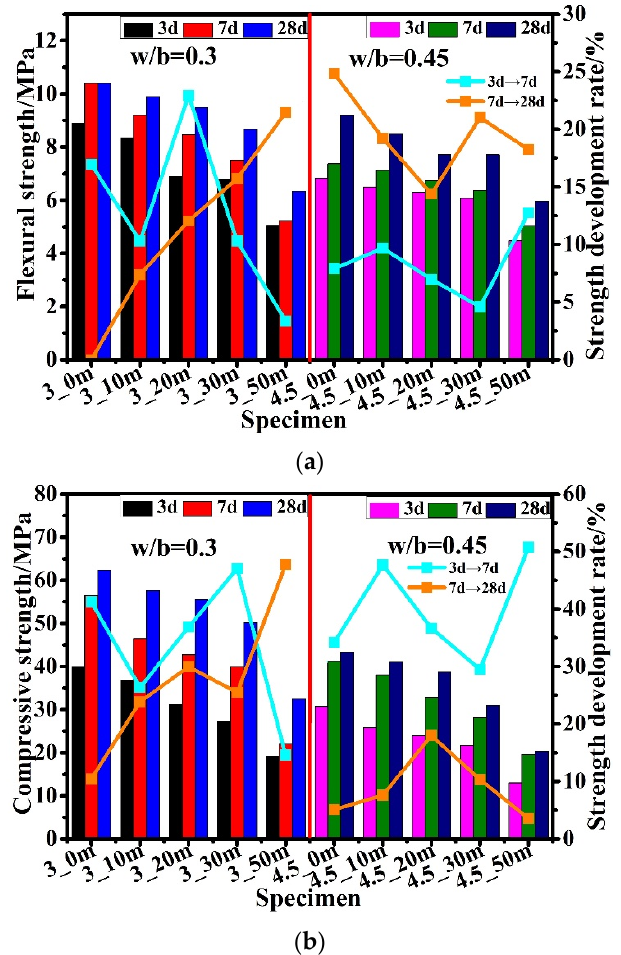
Figure 5. ( a ) Flexural strength; ( b ) compressive